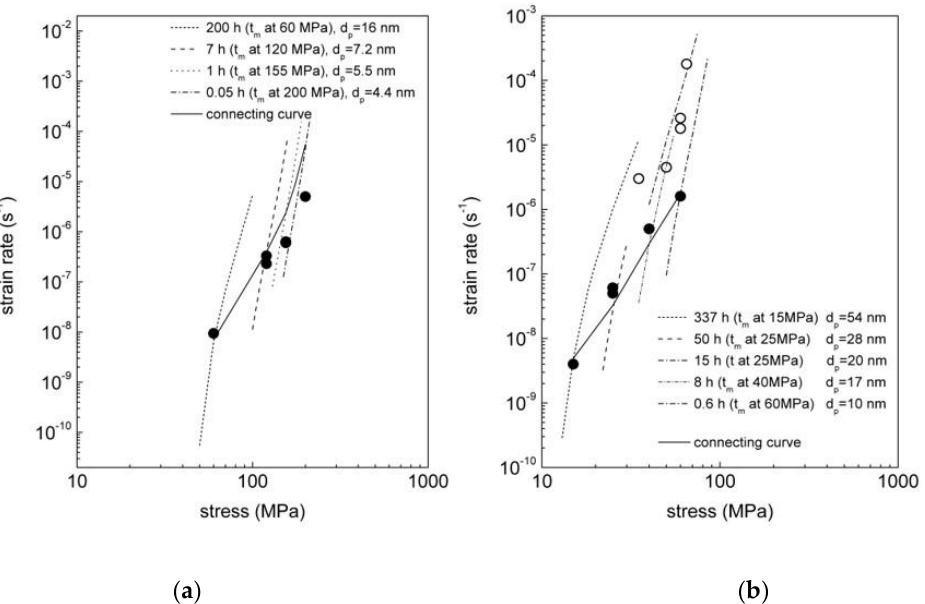
Figure 8. Model curves representing the strain rate variation with stress for microstructures that experienced different durations of exposure under a given load; ( a ) 250 °C; ( b ) 315 °C. Each curve is thus relative to a microstructure equivalent to that observed at t m under a given applied stress (iso-P curves). The open data in ( b ) are from the VLE ( f = 0.5 and 0.22% at 250 and 315 °C respectively).